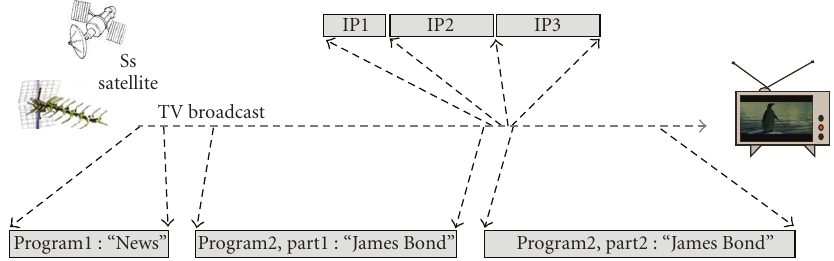
Figure 1: TV broadcast structuring. Detection of program and interprogram